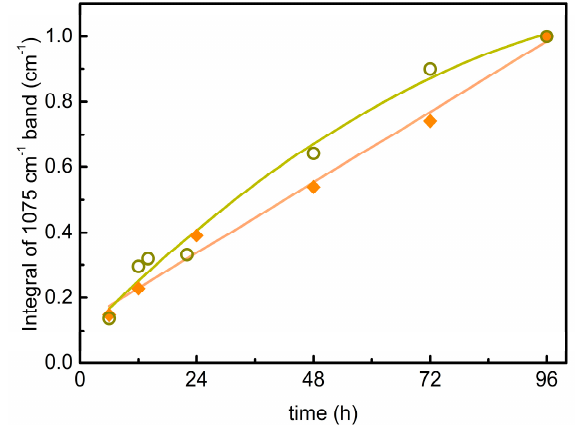
Figure 6. Dependence on time of the integral of the ~1075 cm − 1 band of ethylene carbonate ( orange scatters ) and propylene carbonate ( dark yellow scatters ) on ZIF-8. The intensities reported in the plot are those in Table 2, normalized to the 96 h value. The orange and yellow lines correspond to the linear fitting of the EtC data and the quadratic fitting of the PrC data, respectively.